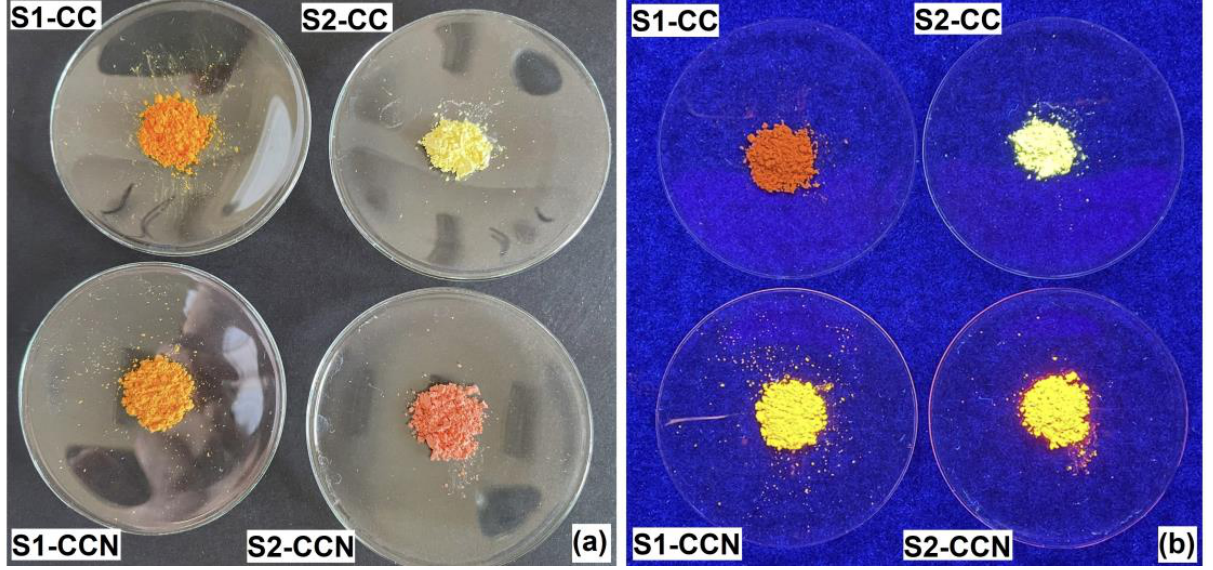
Figure 8. Images of hybrid materials exposed to daylight ( a ) and fluorescence emission during excitation at 365 nm ( b ).